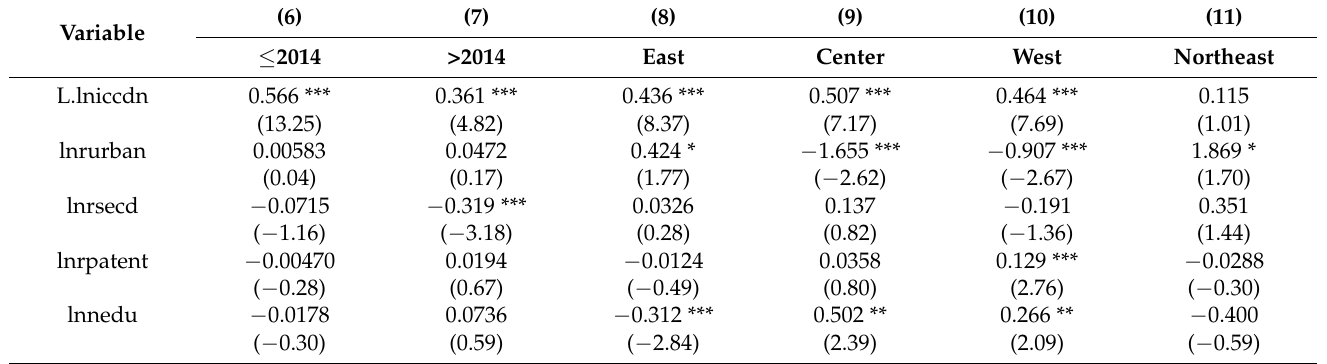
Table 6. The heterogeneity estimation results of influence